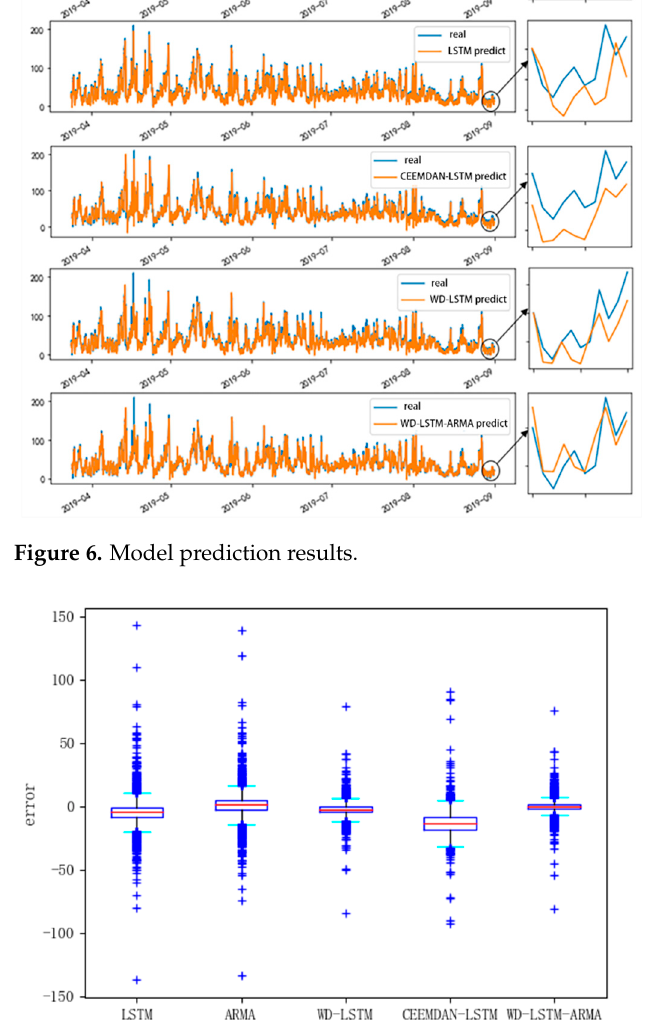
Figure 7. Error box diagram.